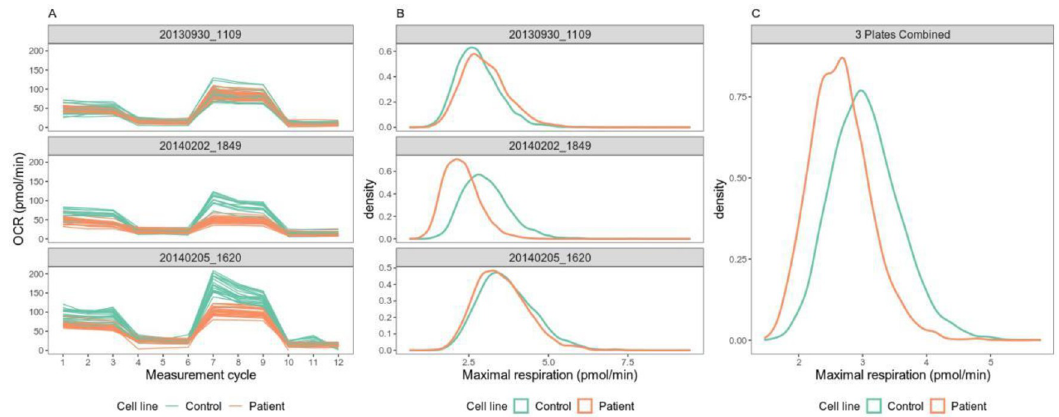
Fig 4. (A) Raw OCR values for the cell line with genetic mutation in SFXN4 gene (patient cell line 61818) in three repeated plates. (B) Posterior distributions of maximal respiration of the cell line with genetic mutation in SFXN4 gene (patient cell line 61818) and the control cell line in the same plate. (C) Posterior distributions of maximal respiration of the cell line after combing all three repeated